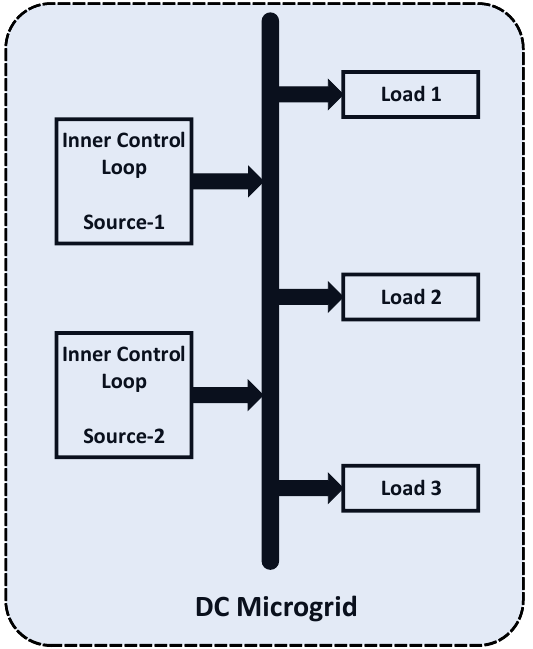
Figure 1. Block diagram showing structure of DC